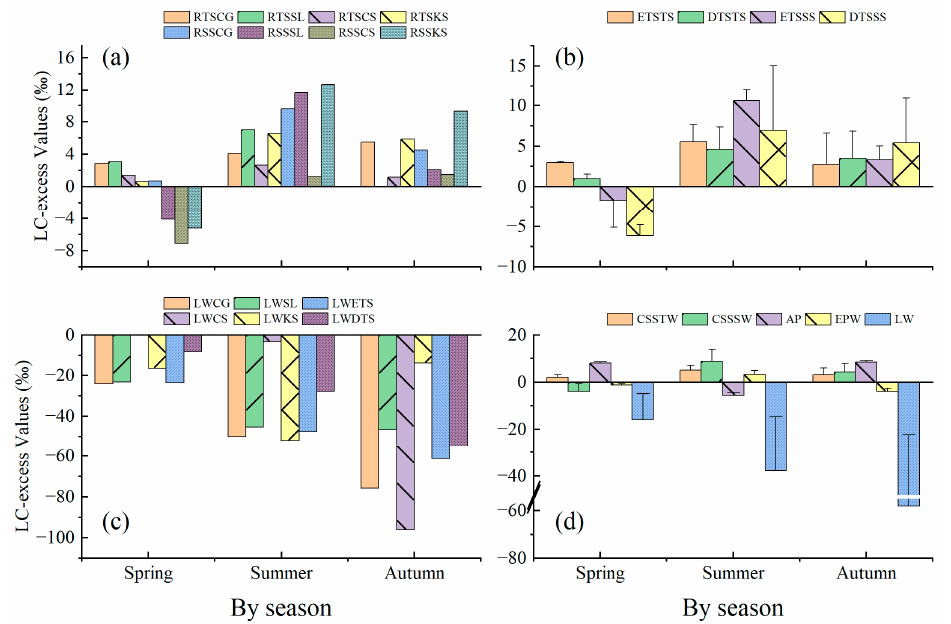
Figure 8. ( a ) Seasonal variation in LC-excess values of rhizosphere soil water of different tree species; ( b ) description of life forms at sample site; ( c ) seasonal variation in LC-excess values of leaf water (LW) of different tree species and different life forms at sample site; ( d ) seasonal variation in LC-excess values of community sample site soil water (CSSTW, CSSSW), atmospheric precipitation (AP), epikarstic water (EPW), and leaf water (LW).